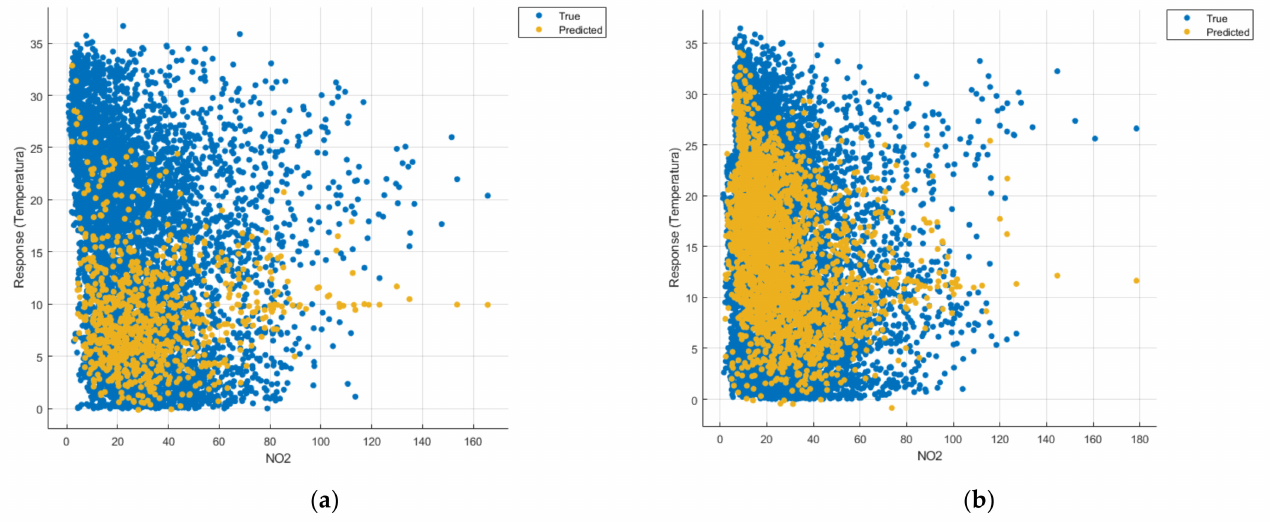
Figure 14. Prediction considering only NO 2 —Fine Gaussian SVM. ( a ) March 2019–February 2020, ( b ) March 2020– February 2021.